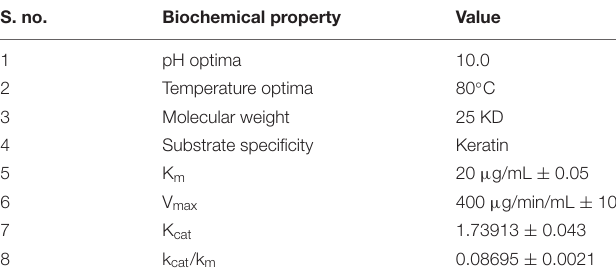
TABLE 2 | Properties of keratinase from Thermoactinomyces sp. strain RM4. S.